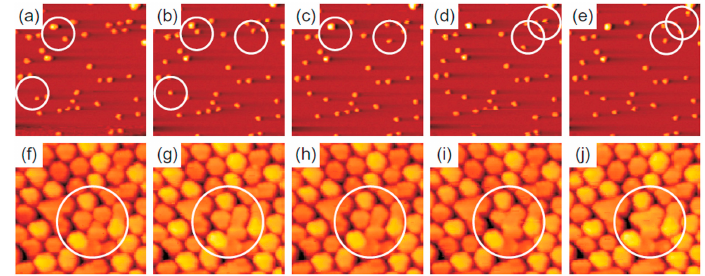
Figure 14. ( a – e ) Scanning Tunneling Microscopy images (25 nm × 25 nm) of 0.01 ML Ir deposited at 350 K on graphene/Ir(111) ( a ) and annealed at 390 K for 120 s ( b ); 240 s ( c ); 360 s ( d ); 480 s ( e ). Circles indicate where modification occur in successive images; ( f – j ) Scanning Tunneling Microscopy images (15 nm × 15 nm) of 1.5 ML Ir deposited on graphene/Ir(111) at 350 K ( f ) and annealed at 450 K for 120 s ( g ); 240 s ( h ); 360 s ( i ); 480 s ( j ). Reproduced from Reference [64] with permission from IOPscience. Table 3. Activation energy for diffusion (E a ) with the corresponding deviation ( Δ E a ), and the pre-exponential factor ν 0 with the corresponding errors (fifth and sixth columns) for the cases of Ir, Pt and W deposited on graphene/Ir(111). Reproduced from Reference [64] with permission from IOPscience.